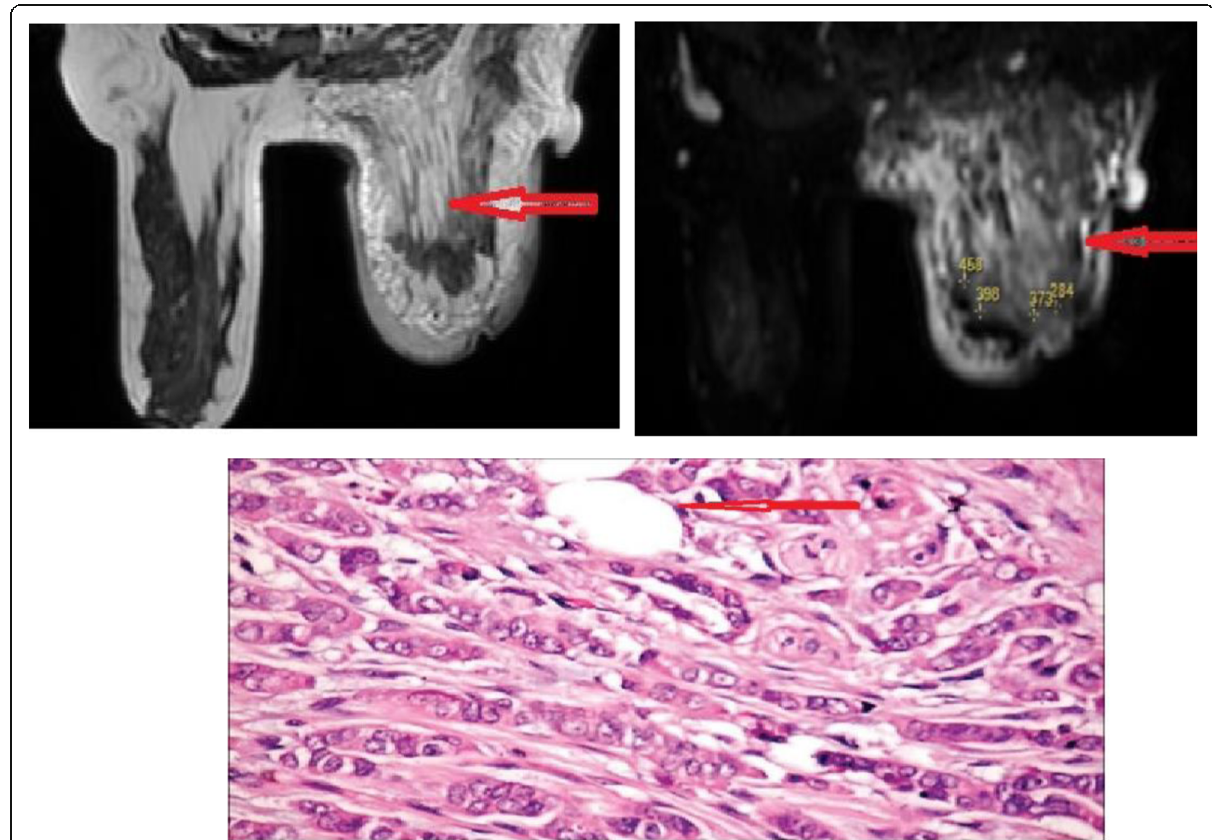
Fig. 5 46-year-old female presented with right breast diffuse swelling with palpable retroareolar lump. Right breast diffuse edema and skin thickening with multiple ill-defined infiltrative lesions displaying high signal on T2. The lesions show restricted diffusion. ADC values range between 0.7 to 1.3 × 10 − 3 mm 2 s. The pathological diagnosis is inflammatory